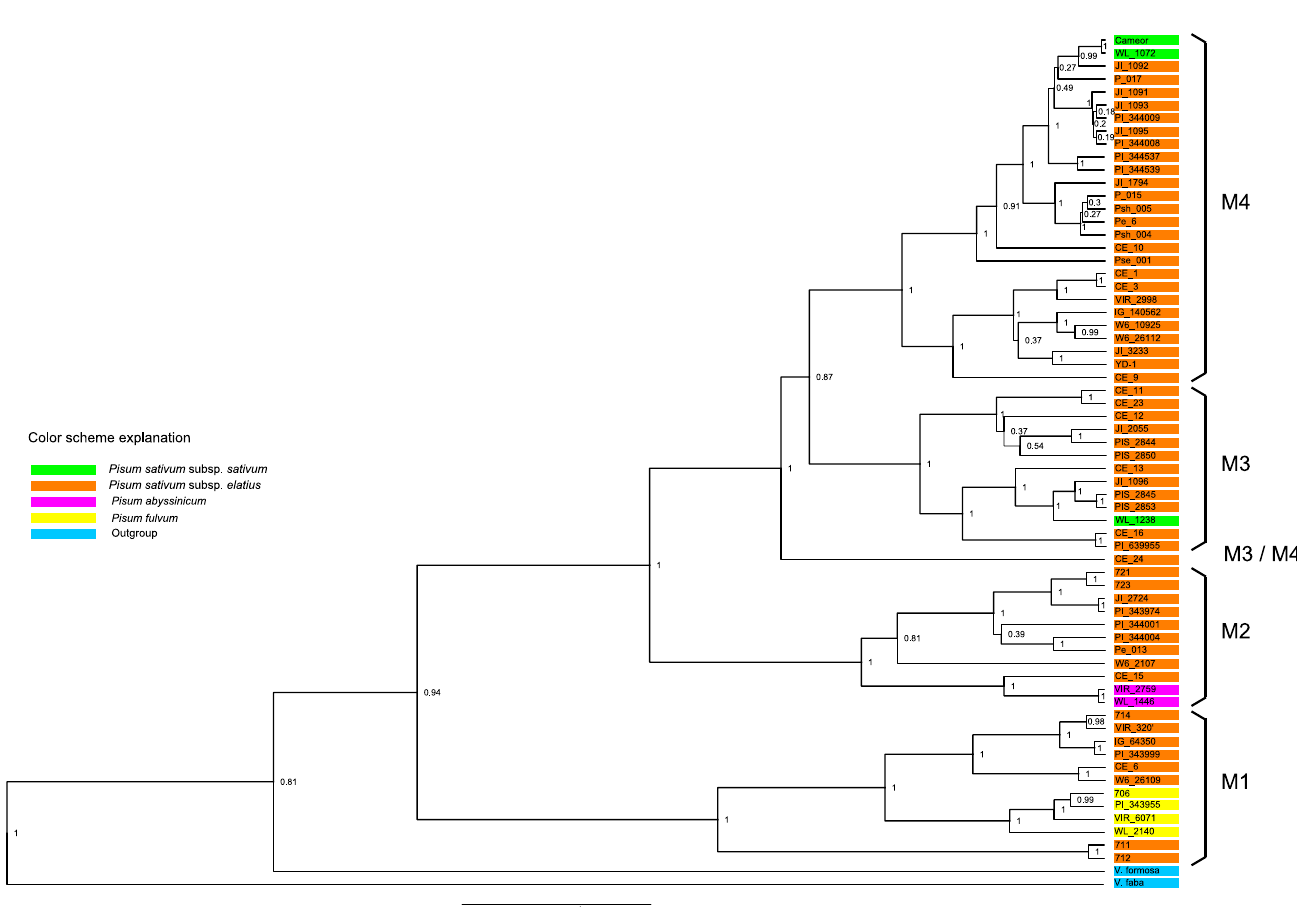
Figure 2. Reconstruction of phylogeny of pea accessions with Bayesian MCMC method on the basis of the mitochondrial genomes. Main phylogenetic branches are denoted as M1 – M4. Designation of taxonomic attribution and the outgroup as in Figure 1.